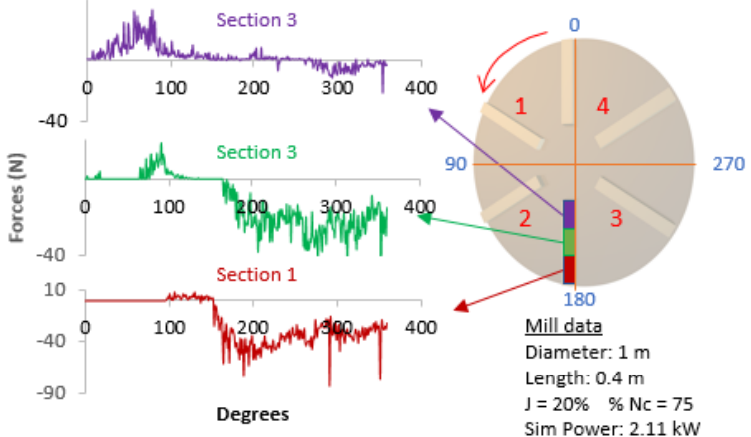
Figure 5. Tangential forces acting on long end lifters.